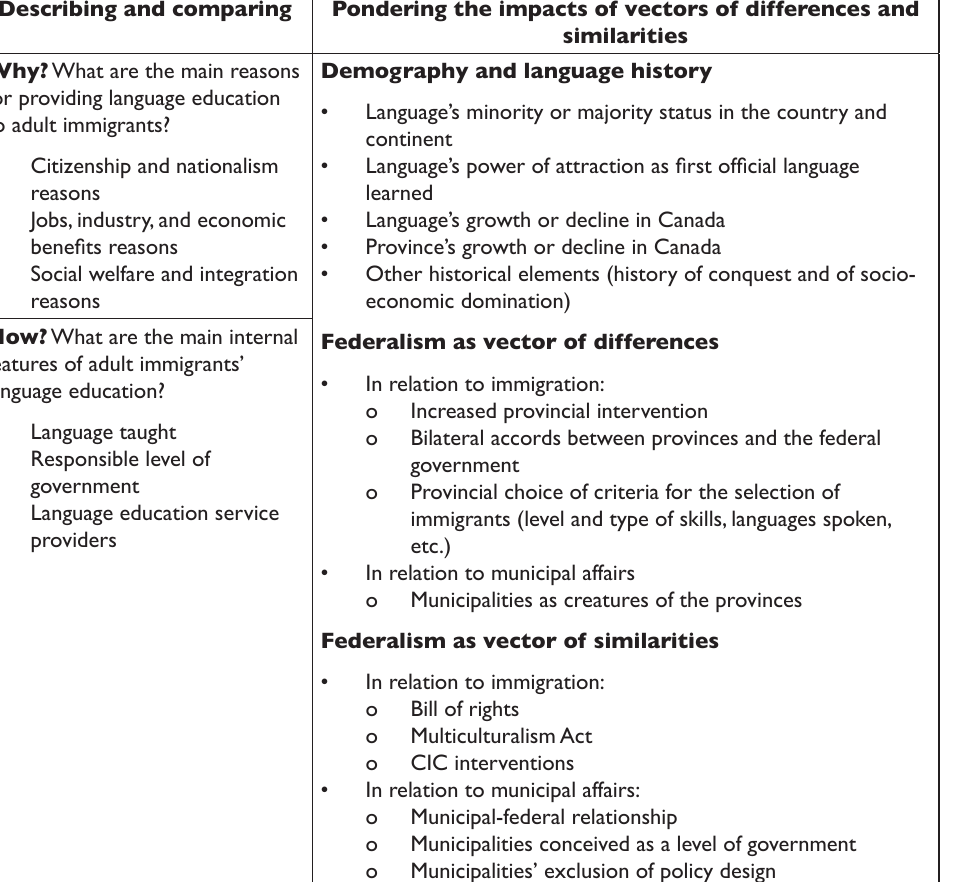
Table 3: Analyticalframeworkandapproach Pondering the impacts of vectors of differences